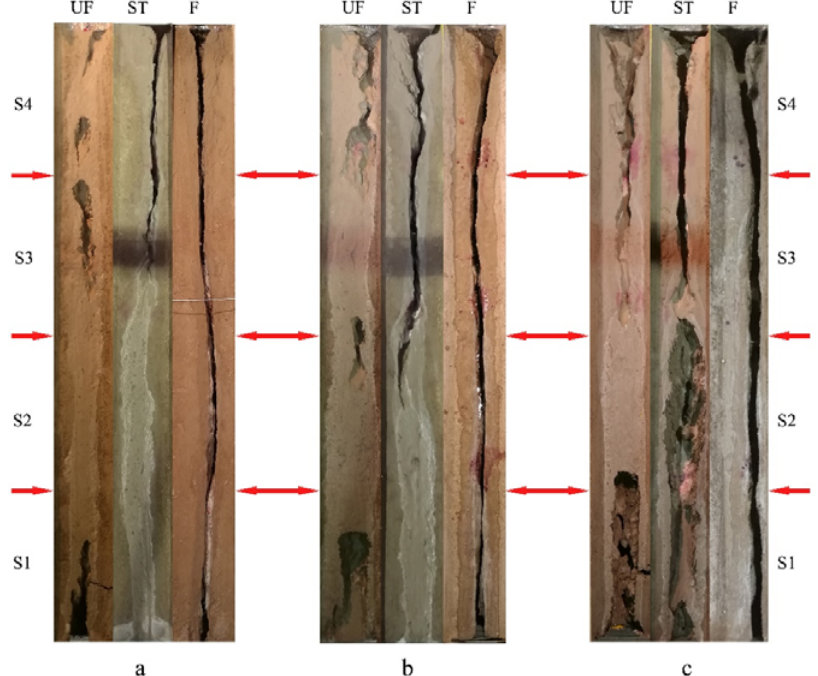
Figure 4. Eroded topography on the unfrozen (UF), shallow-thawed (ST), and frozen (F) slopes under the flow rates of 1 L/min ( a ), 2 L/min ( b ), and 4 L/min ( c ). 3.2. Variation of the Runoff Energy Consumption over Unfrozen, Shallow-Thawed, and Frozen Slopes